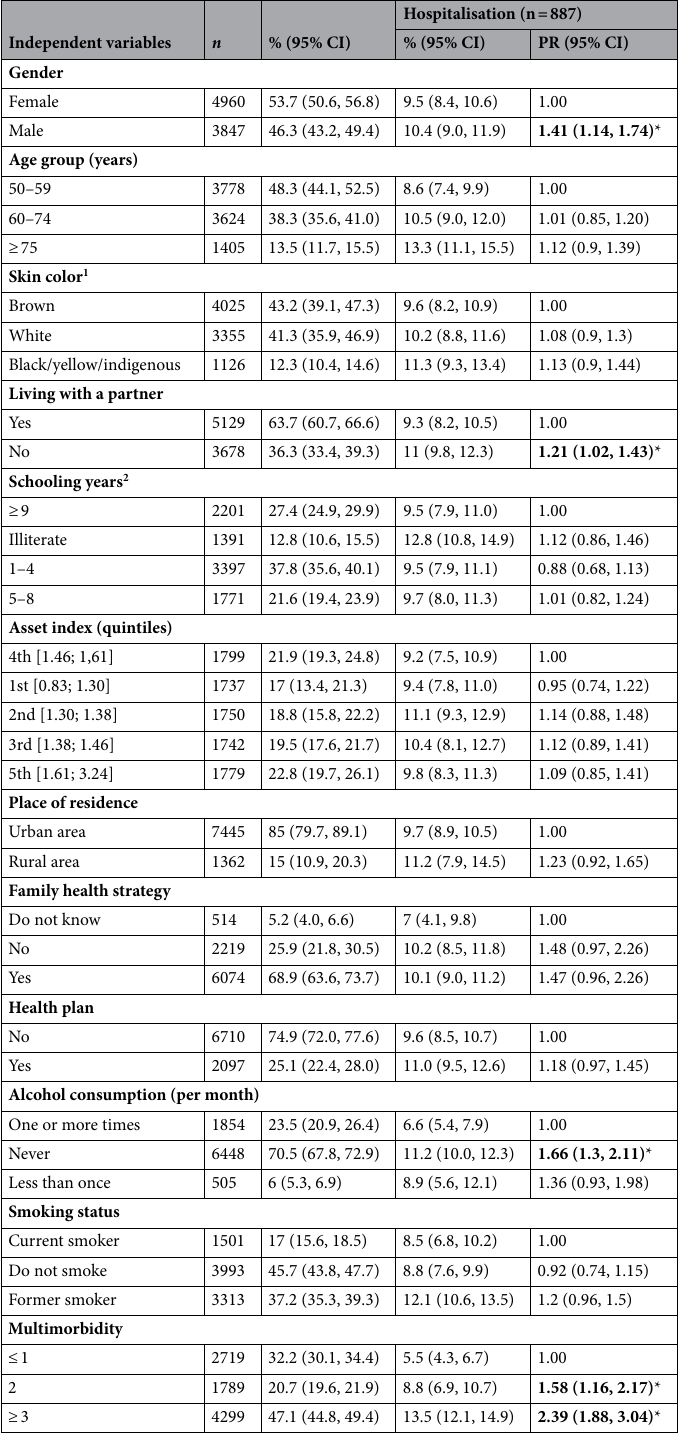
Table 1. Prevalence of hospitalisation and its association with sociodemographic, lifestyle and multimorbidity variables in older adults from the ELSI-Brazil cohort (2015–2016). 95% CI 95% confidence interval, PR prevalence ratio, n unweighted number of choices. Relative frequencies (%) and weighted confidence intervals. 1 n = 8506. 2 n = 8760. * p <